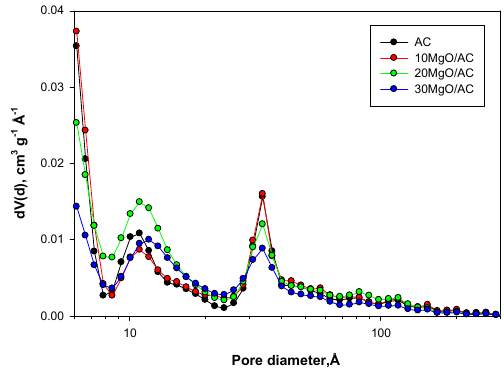
Figure 1. Pore size distribution (PSD) of activated carbon (AC) and of 10, 20, and 30 wt% MgO/AC.